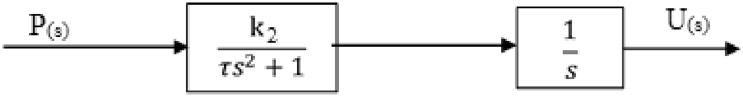
Transfer function block for spray tip velocity.